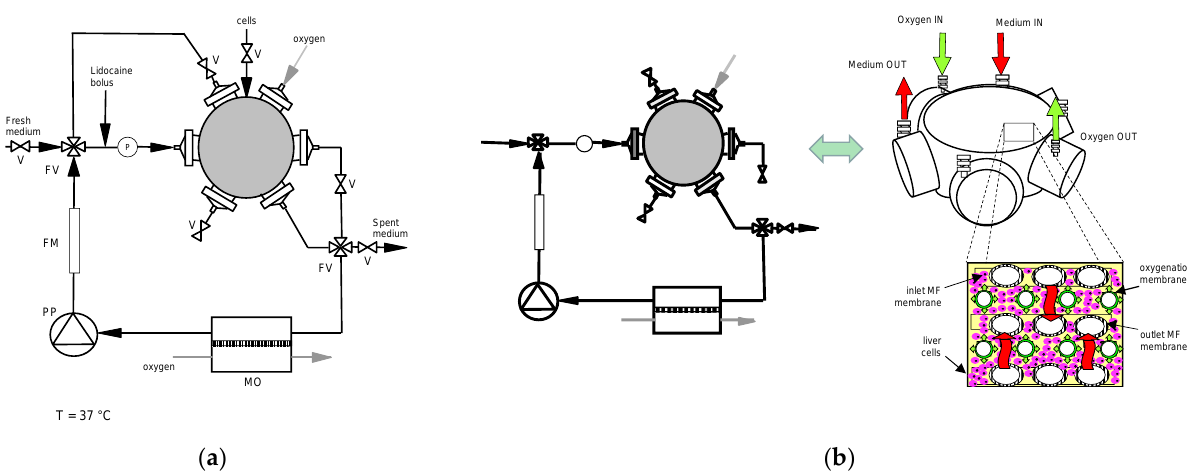
Figure 1. Three-dimensional bioreactor and experimental apparatus: ( a ) scheme of the experimental apparatus used for culture and kinetic experiments with the 3D bioreactors: FM—flowmeter; FV—four-way valve; MO—membrane oxygenator; PP—peristaltic pump; V—valve; ( b ) scheme of apparatus and 3D bioreactor operated in bleed-feed perfusion mode.